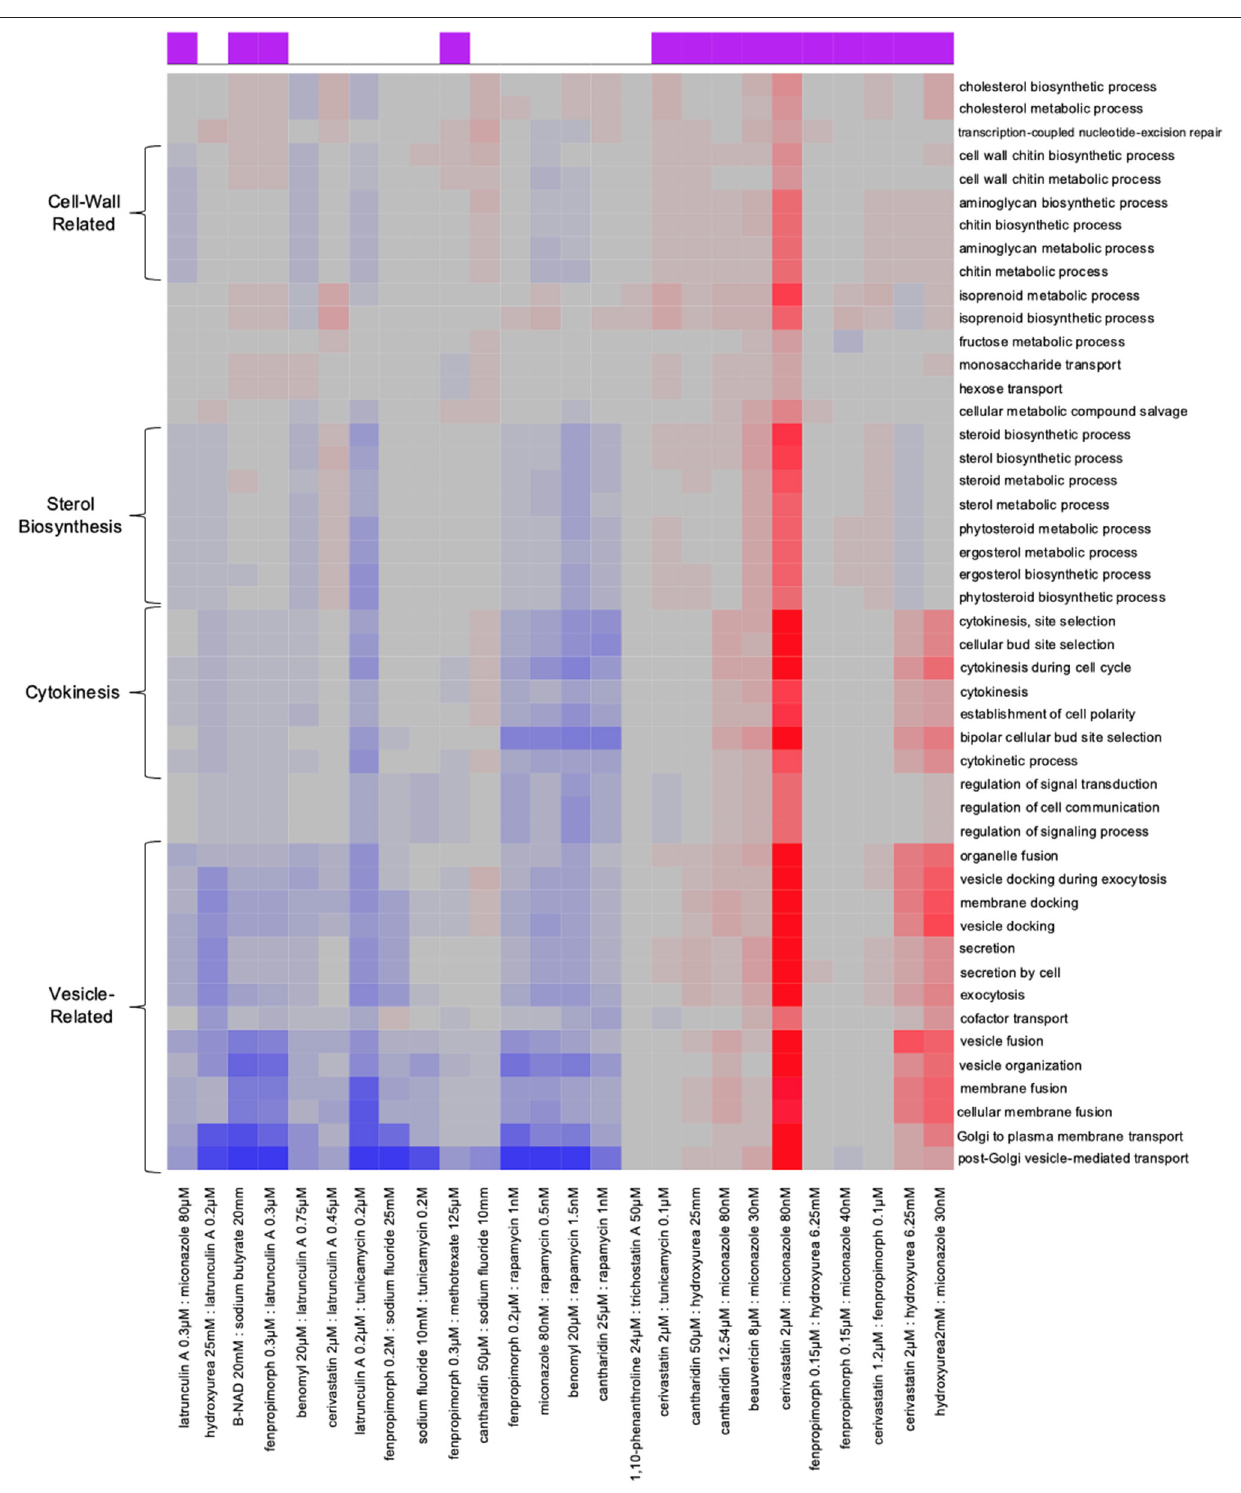
Frontiers in Fungal Biology |